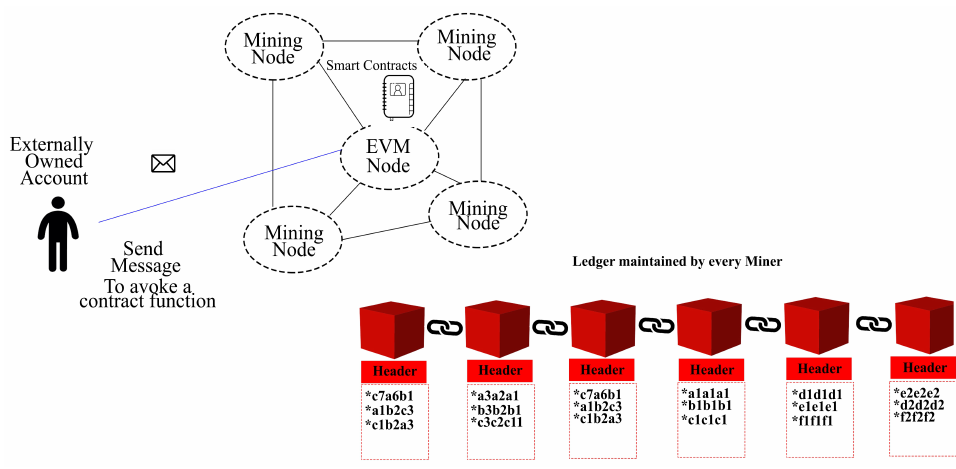
Figure 3. Ethereum Blockchain architecture.